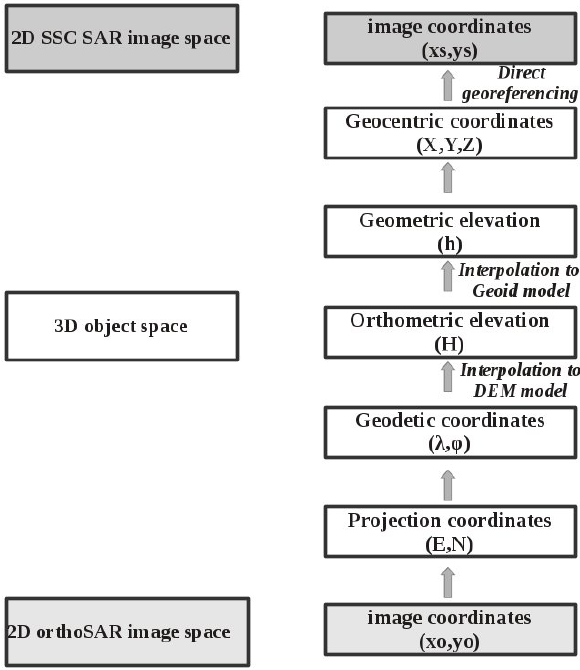
Figure 2: Transformations of coordinate